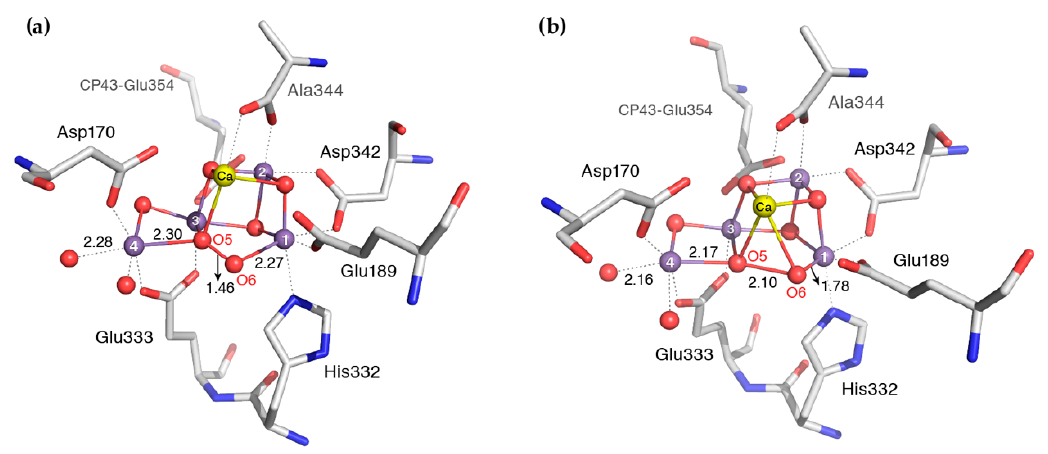
Figure 6. ( a ) Crystallographic model of the S 3 state proposed from the X-ray free-electron laser (XFEL) study of Suga et al. [46] (5WS6, monomer A) and ( b ) S 3 model proposed from the XFEL study of Kern et al. [47] (6DHO, monomer A). Selected distances are shown in Å.